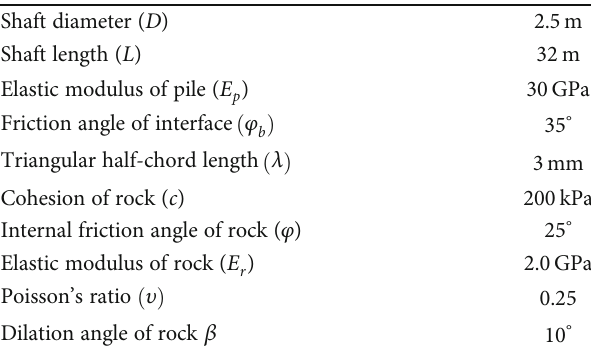
Figure 5: The sketch of plastic depth and elastic depth. Table 1: The basic parameter values for veri fi